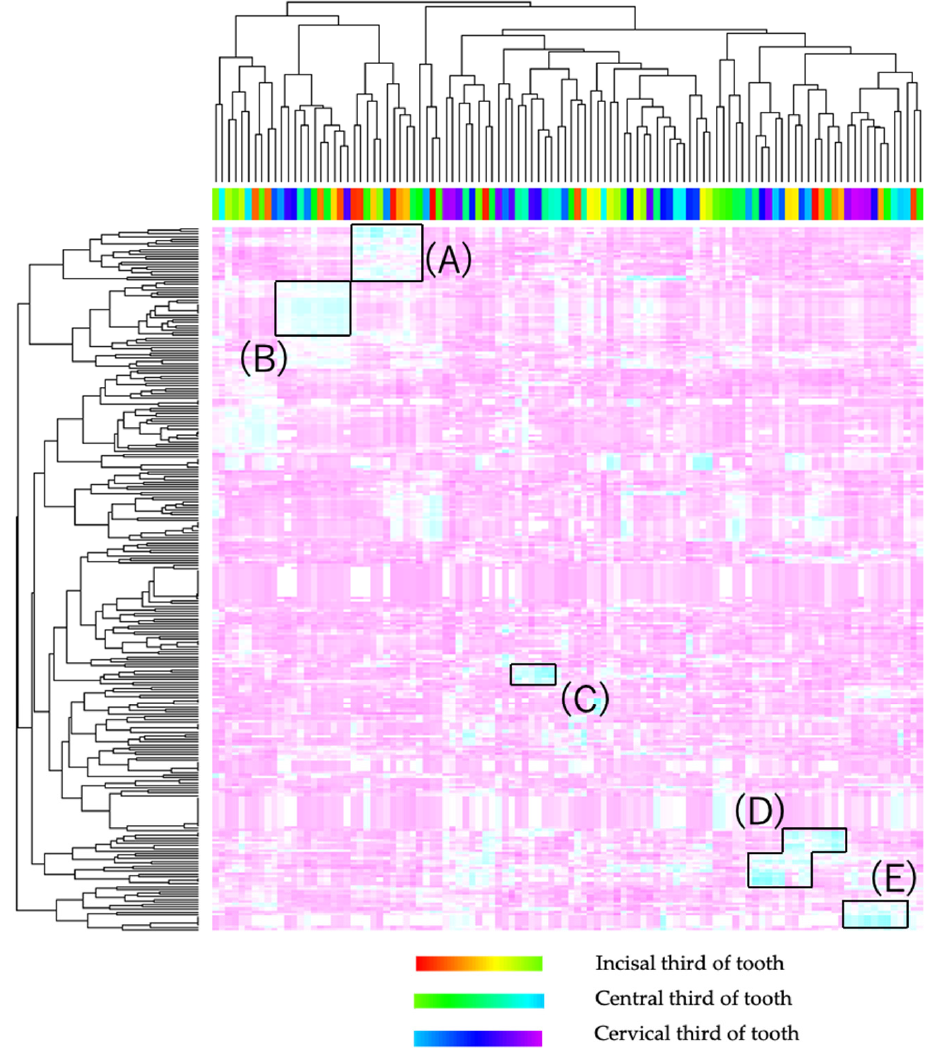
Figure 4. Correlation heatmap of Δ Q value and species. The order of tooth surface in legend is maxillary to mandibular, right to left, distal to mesial. Detailed correlations are shown in the Table S8. Sky blue area indicate positive correlations. Some of the sky-blue area contains site specific species: Aggregatibacter , Alloprevotella , Anaerococcus , Bifidobacterium , Porphyromonas , Prevotella , Treponemma , Vagococcus , Veillonella , and Streptococci . ( A – E ): Cluster of highly positive correlation between WSLs and species.